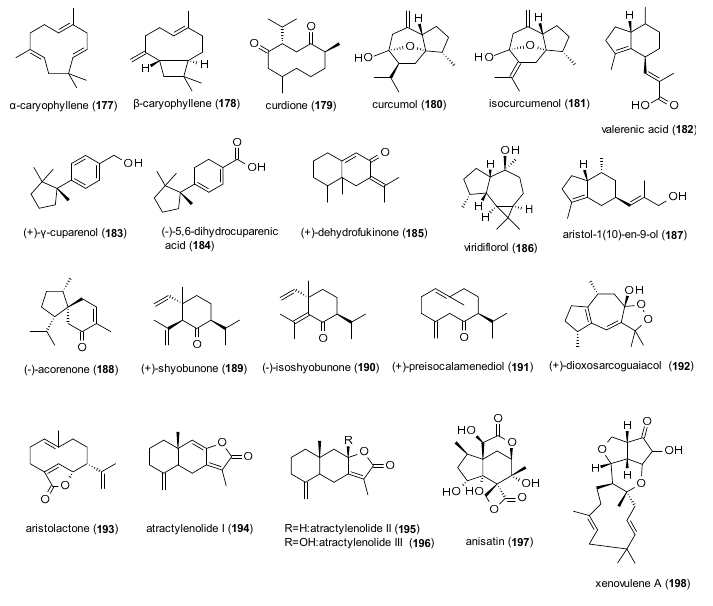
Figure 12. Chemical structures of sesquiterpenes with reported GABA(A)-receptor modulating activity.